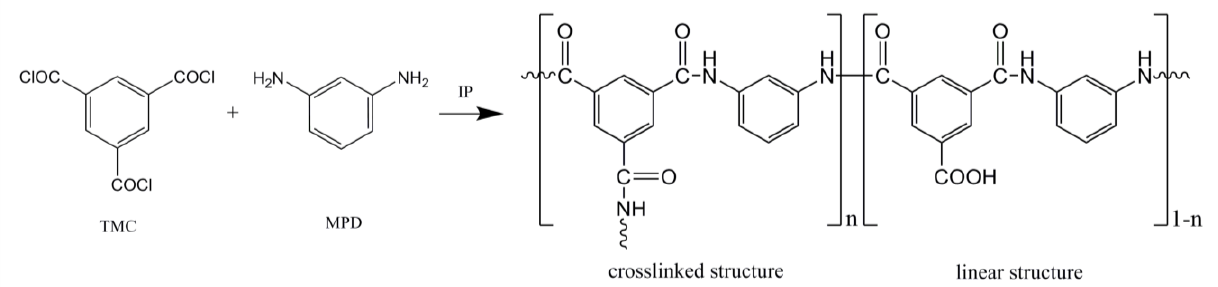
Figure 7. Interfacial polymerization reaction to form polyamide dense layer based